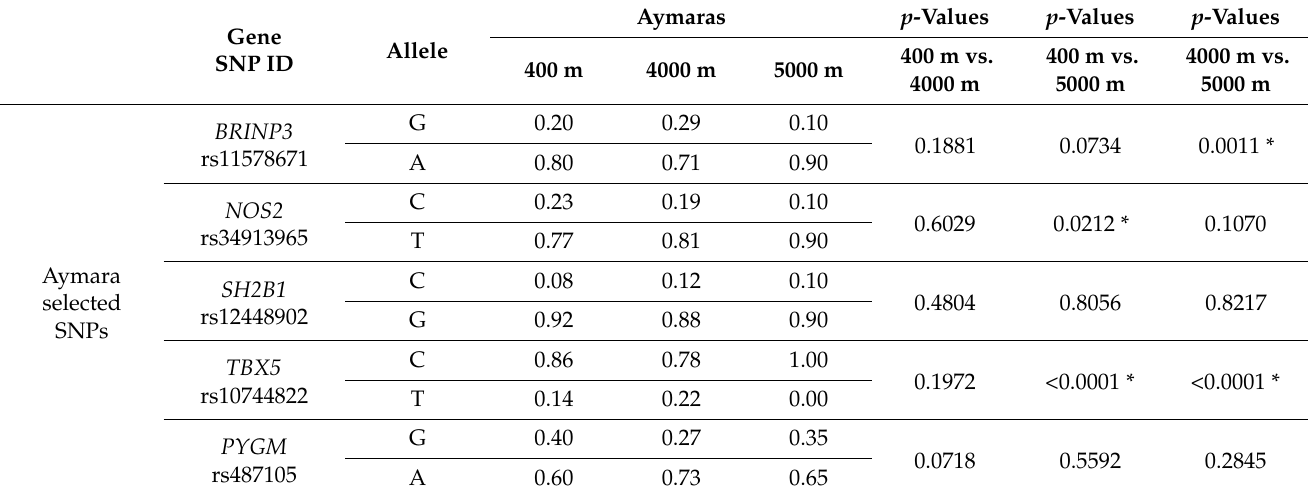
Table 2. Allele frequencies in Aymaras at different